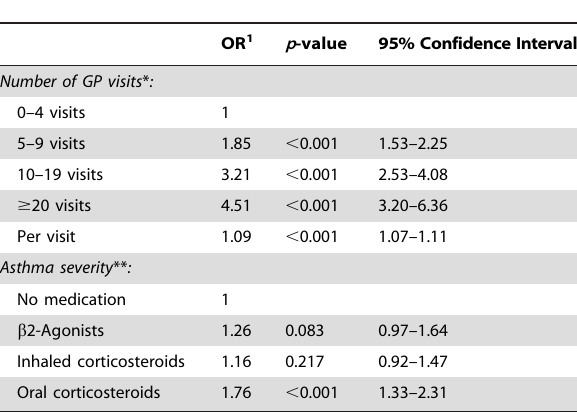
Table 1. Association between predictor variables